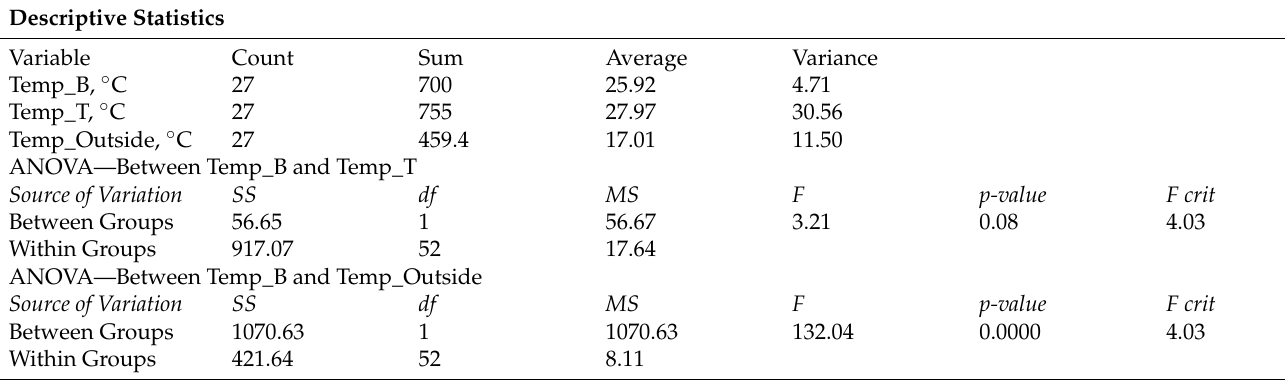
Table A3. Descriptive Statistics of Temperature Profile and ANOVA Test Statistics (Period 3).